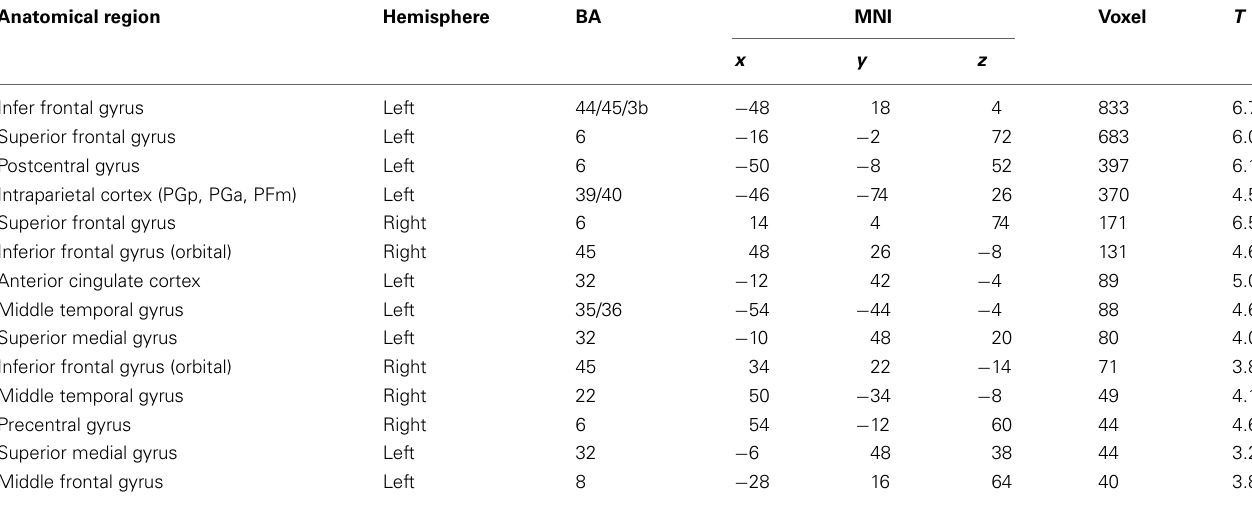
All clusters significant after correction for multiple comparisons (FDR, p < 0.05).